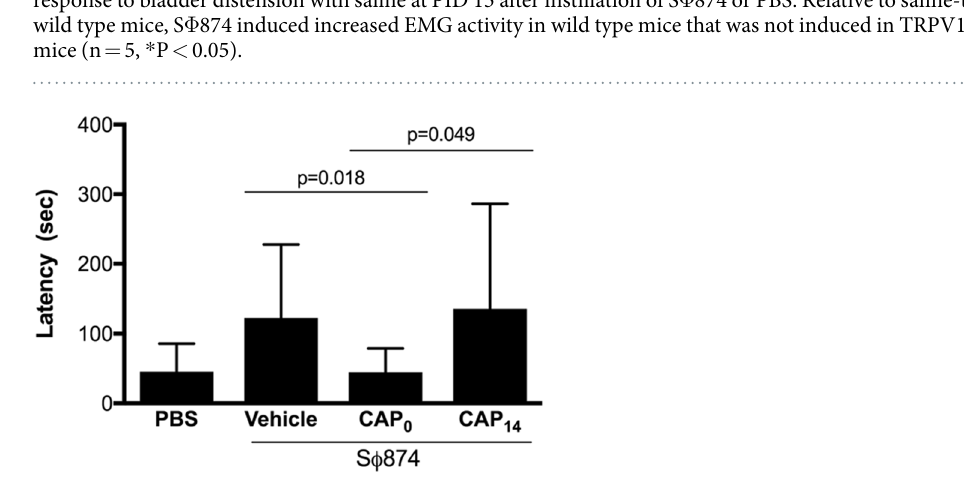
suggesting that S Φ 874-induced chronic pain is also associated with depressive/anxious behavior (Fig. 3). In con- trast, mice treated with capsazepine at PID 0 did not develop increased latency. However, S Φ 874-infected mice treated with capsazepine at PID 14 showed increased latency times similar to vehicle-treated, S Φ 874-infected mice. Like the development of post-UTI pain itself, these data suggest that TRPV1 mediates the establishment of cognitive dysfunction consistent with depression that associated with post-UTI chronic pain, but TRPV1 is dispensable for maintenance of depressive behaviors.